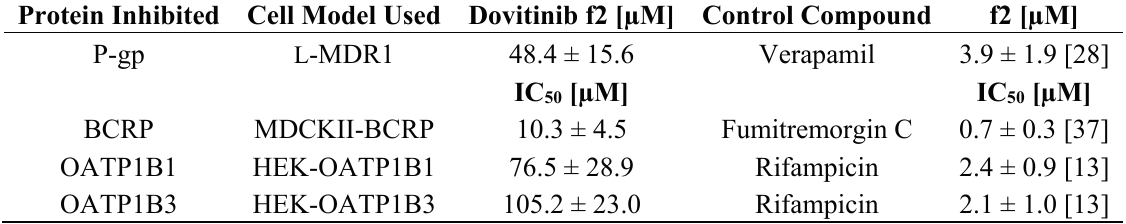
Table 1. IC 50 and f2 (concentration needed to increase baseline fluorescence two-fold) values for transporter inhibition assays for dovitinib and the corresponding control